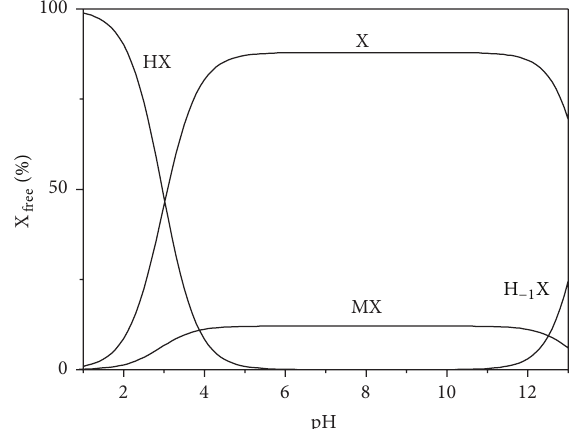
Figure 2: Distribution diagram of species of anion “X” of synthetic saliva versus pH, at 𝑡 = 37 ∘ C, according to S 3